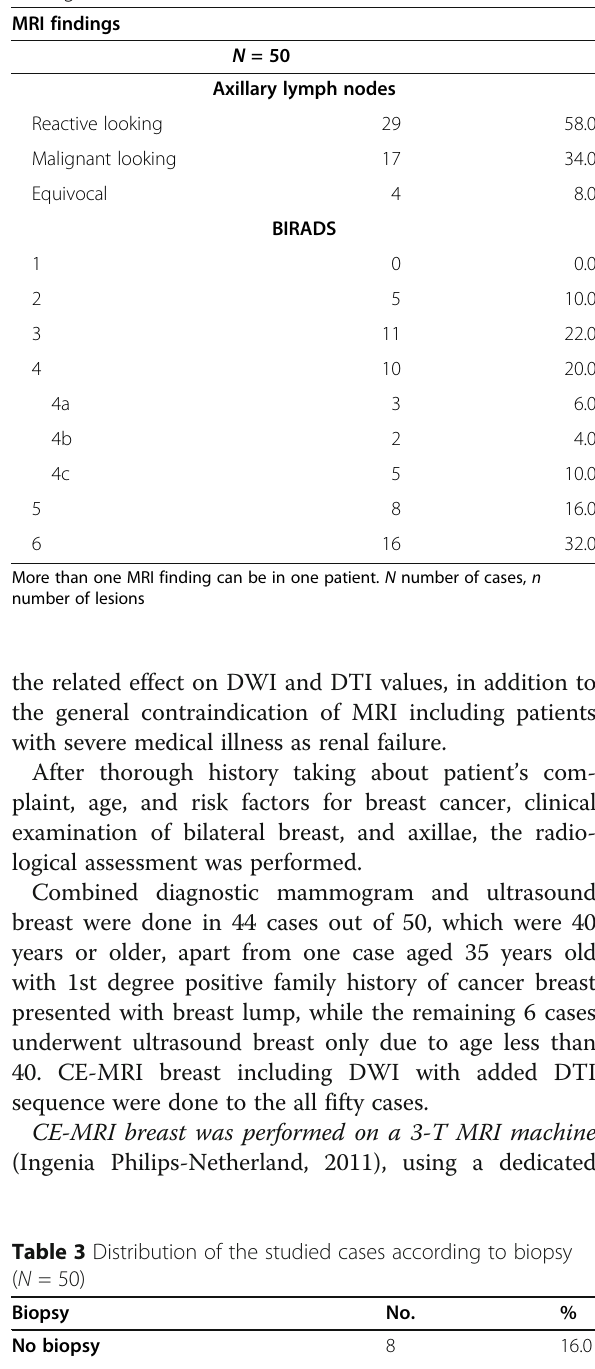
Table 2 Distribution of the studied cases according to CE-MRI findings ( N = 50) (Continued)